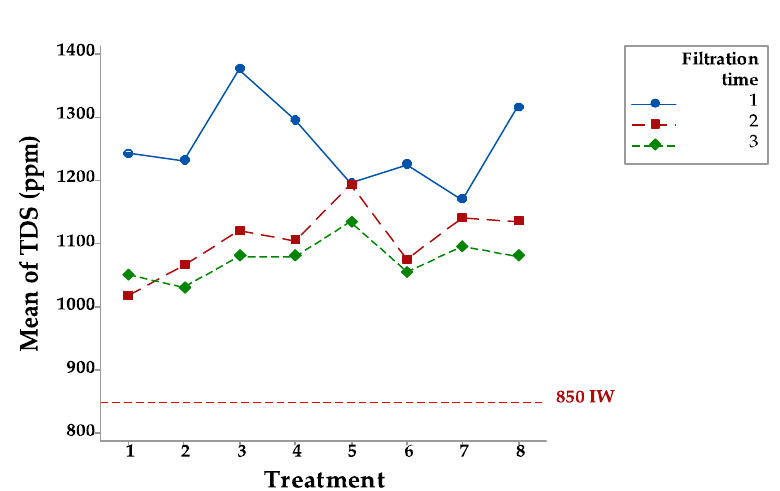
Figure 1. Levels of pH ( a ), EC ( b ), and TDS ( c ) in the eight treatments and three filtrations.